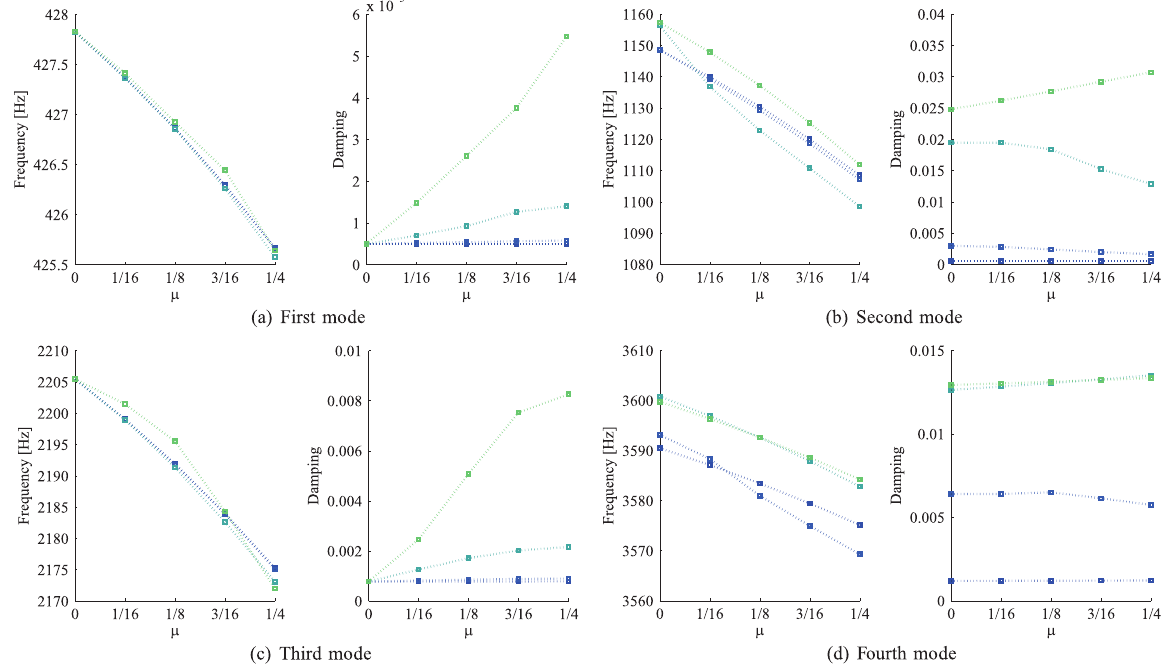
Fig. 8. Frequency and damping in the second case for three weighting matrices ( (cid:2) : uncontrolled, (cid:2) : Q 1 , (cid:2) : Q 2 , (cid:2) : Q 3 ).